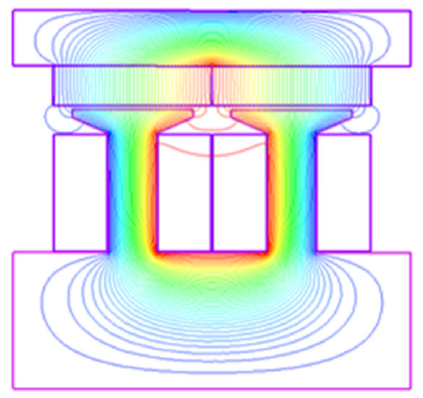
Figure 5. The 2D magnetic flux distribution of the proposed EMLS. Table 1. Specification of the verified model.